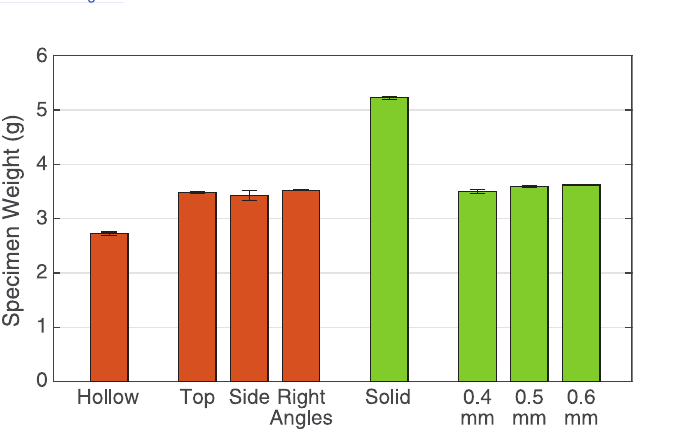
Fig 8. Experimental setup. (Left) All of the specimens used for testing. (Right) The specimen is placed at the center of the platen. As the actuator moves the platen down, the specimen is compressed and the resulting force is read from the load cell beneath.